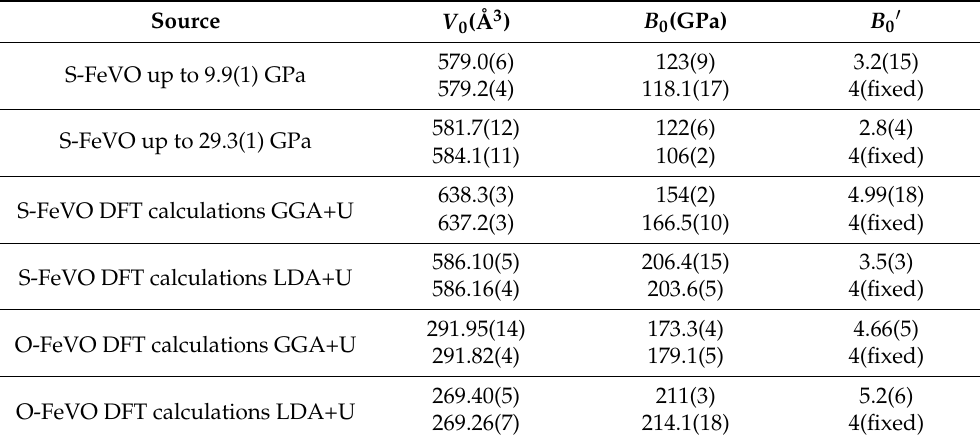
Table 3. Experimental and calculated EOS Parameters for FeV 2 O 4 . Ambient pressure unit-cell volume, V 0 , bulk modulus, B 0 , and its first pressure derivative, B 0 (cid:48) . Source V 0 (Å 3 ) B 0 (GPa) B 0